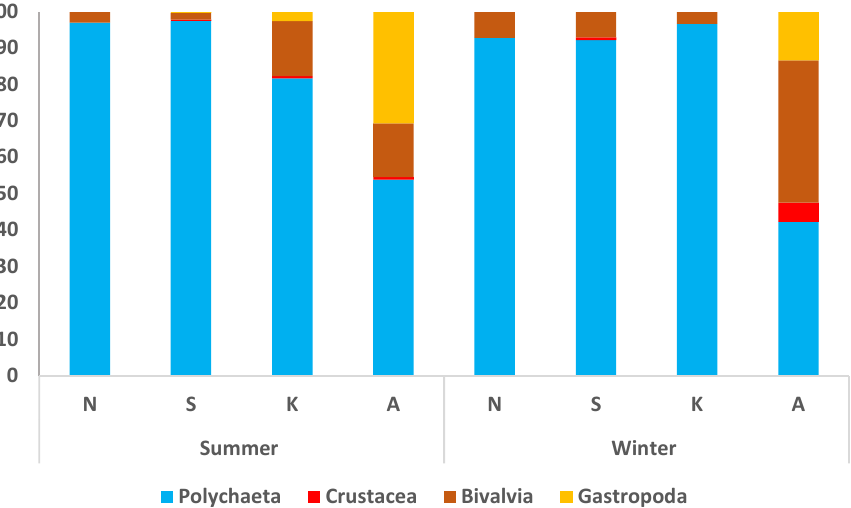
Figure 4. Relative abundance of the major taxonomic groups in the four study areas in the summer and winter seasons.